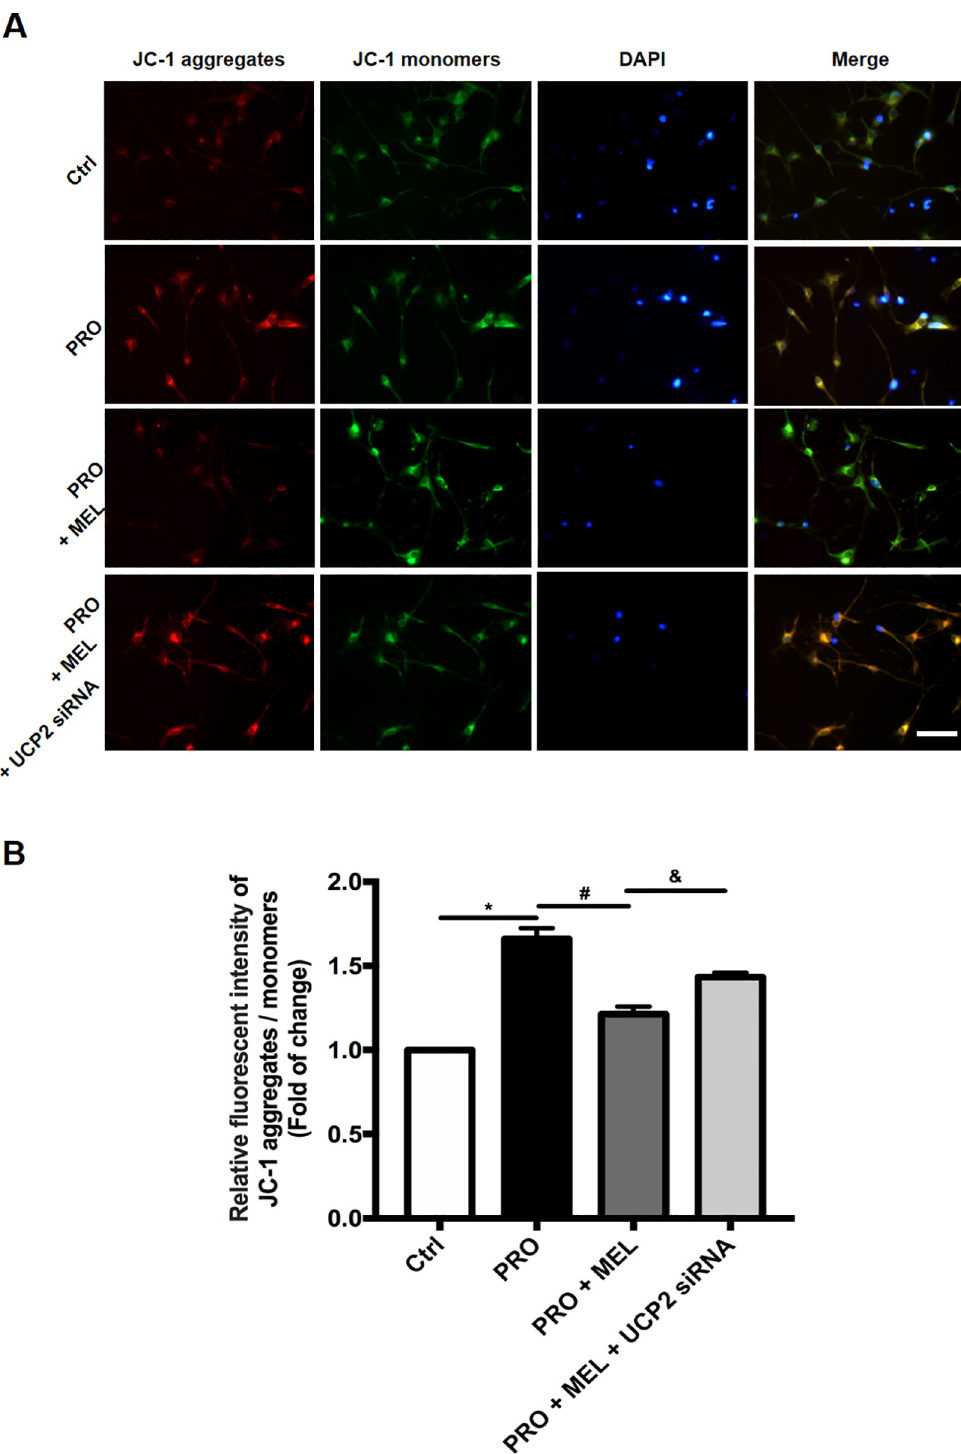
Fig 4. Membrane potential ( Δ C m) was measured by using a fluorescent probe JC-1 assay system in microglia. The ratio of fluorescence intensities Ex/Em = 490/590 and 490/530nm (FL590/FL530) were recorded to delineate the Δ C m level of sample. Δ C m of control, PRO, MEL+PRO with or without UCP2 siRNA-treated microglia (A) and related quantification (B) was shown. The average of three to five determinations for each group is shown. Statistical significance between groups was evaluated by one-factor ANOVA. Data were mean ± SEM. n = 3, � p < 0.05 vs. the control group, # p < 0.05 vs. PRO group, & p < 0.05 vs.100 μ M MEL-treated group. Scale bar: 30 μ m. https://doi.org/10.1371/journal.pone.0212138.g004 PLOS ONE | https://doi.org/10.1371/journal.pone.0212138 February 11,